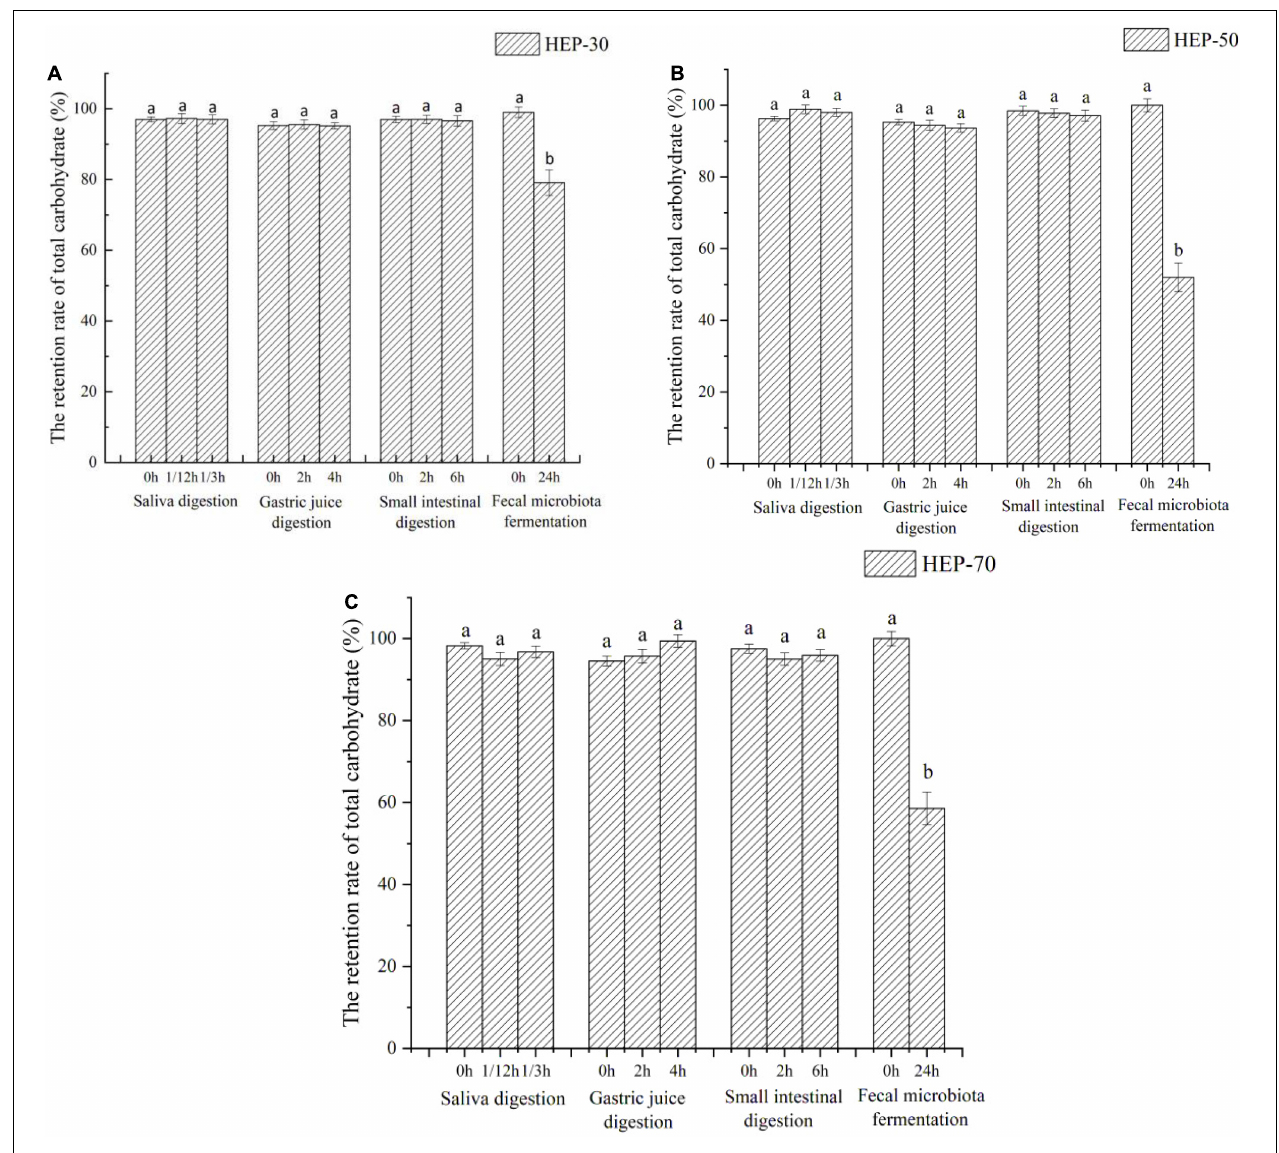
FIGURE 2 | The retention rate of total carbohydrate of HEP-30 (A) , HEP-50 (B) , and HEP-70 (C) during the reaction. The retention rate of total carbohydrate% = (the content of total carbohydrate during the reaction/the content of total carbohydrate before the reaction) × 100%; Data are means ± SD (3 independent experiments × 3 replication). a , b Different lowercase letters indicate significant differences ( p < 0.05) between fermentation 0 and 24